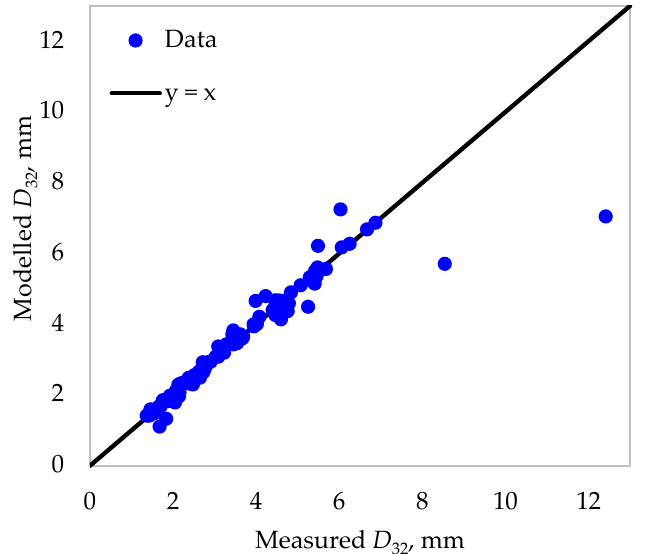
Figure 4. Measured versus modelled Sauter diameters: robust linear regression in the presence of churn-turbulent conditions.